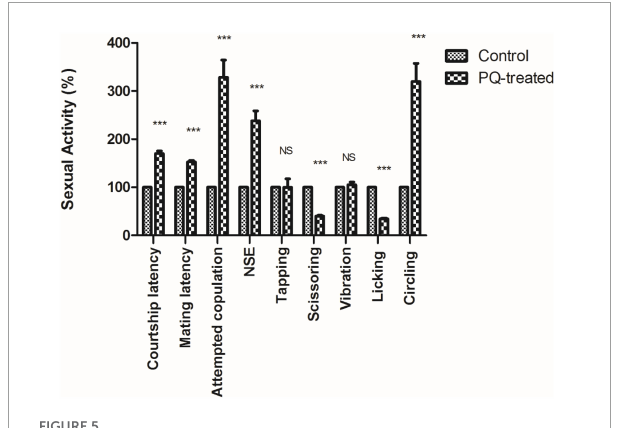
FIGURE5 Sexual dysfunction precedes motor dysfunctions in the Drosophila model of Parkinson’s disease (PD). Paraquat (PQ) treated males exhibited following courtship anomalies when compared to control males, such as increased courtship latency, mating latency, attempted copulation, NSEs, and circling behavior but decreased scissoring and licking behavior. However, there was no difference between control and treated in behaviors such as tapping and vibration. A Statistical analysis was performed using a t -test (compared to control). *** p < 0.0001. NS, not-significant.